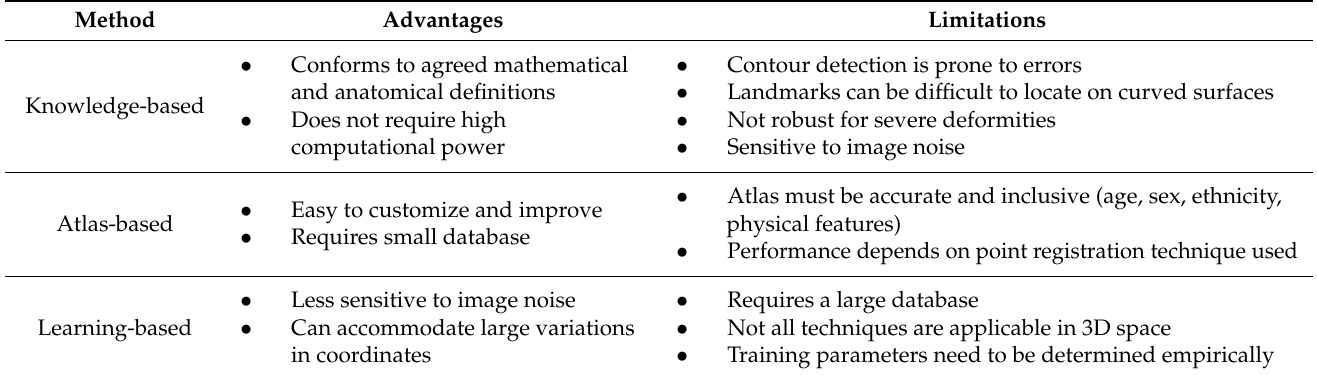
Table 3. Comparison of automated landmark placement